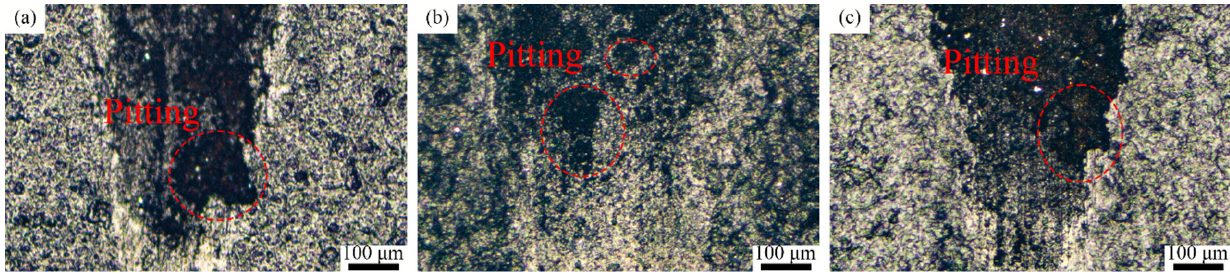
Figure 7. Wear marks of the composite coating under oil lubrication conditions. ( a ) T1.5 coating; ( b ) T2 coating; ( c ) T2.5coating.